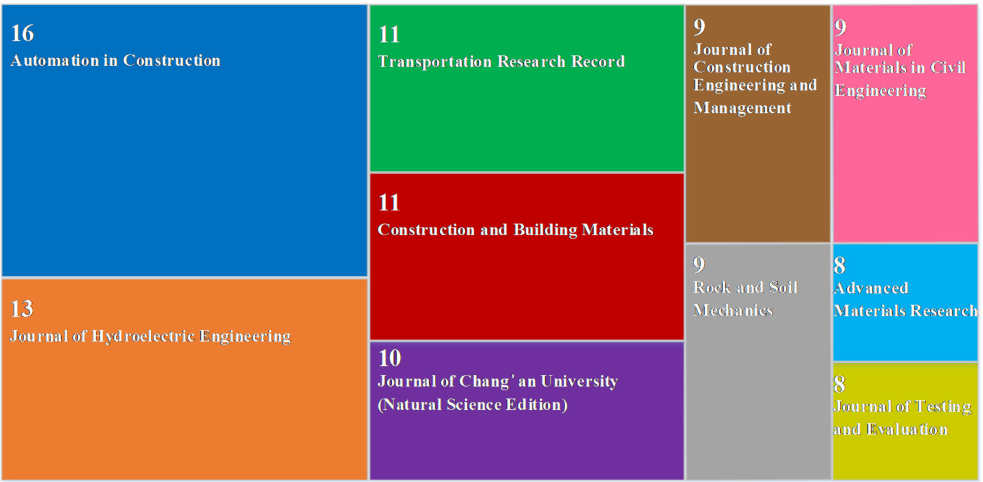
Figure 3. Top 10 authors in search of related literature by key words.